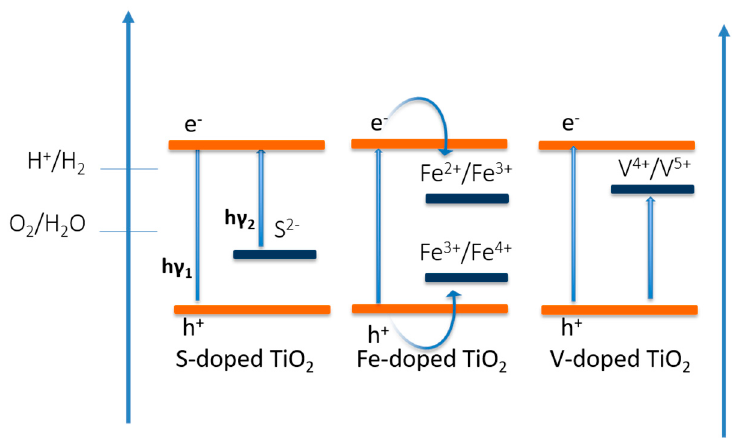
Molecules 2016 , 21 , 900 10 of 28 Figure 4. Schematic band gap diagram of TiO 2 . Figure adapted from references [4,149] of Moniz et al. and Miao et al. works respectively. The other alternative method to extend the photocatalytic activity of TiO 2 to visible light region is to dope this material with carbon. For instance, Faria et al. have reported doping of TiO 2 with carbon nanotubes (CNTs) [154]. Although different mechanisms have been proposed to explain this enhancement, the mechanism of synergic effect of carbon on TiO 2 remains unclear. Three mechanisms have been explored to describe the synergetic effect of carbon on TiO 2 . The first possible mechanism is carbon can play the role of an electron sink, which can effectively prevent the recombination process [155]. Another mechanism proposes carbon as a photosensitizer, which can pump electrons into TiO 2 conduction band [156]. Besides the proposed mechanisms, carbon can also act as template to disperse the TiO 2 particles and hinder the agglomeration of TiO 2 nanoparticles [157]. Unlike non-metal ion doping, metallic dopants usually introduce additional energetic levels in the band gap, which reduce the energy barrier and induce a new optical absorption edge [158,159].